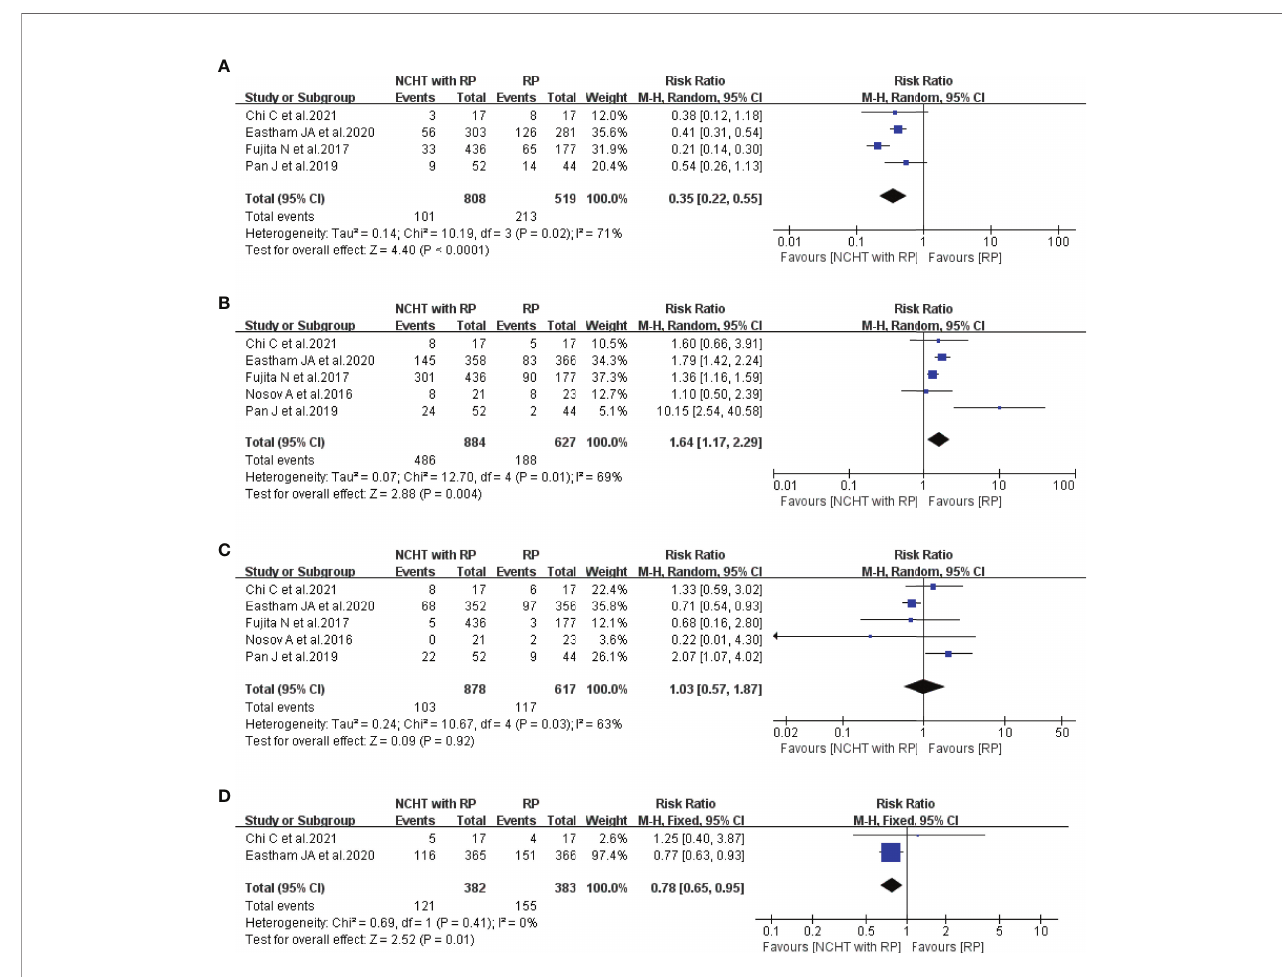
FIGURE 2 | Meta-analyses of the pathological outcomes of patients administered NCHT plus RP versus RP alone (risk ratios). (A) positive surgical margin, (B) pathological downstaging, (C) lymph node involvement, (D) seminal vesicle invasion. NCHT, neoadjuvant chemohormonal therapy; RP, radical prostatectomy; CI, con fi dence